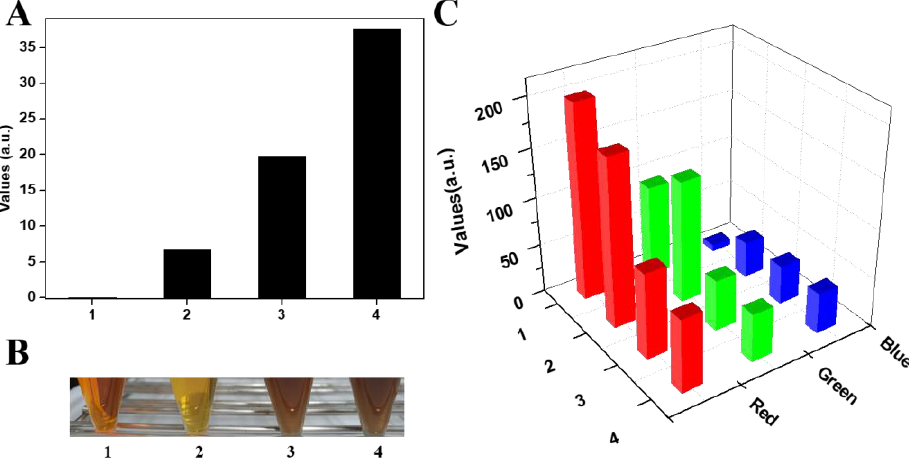
Figure 7. ( A ) Spectral responses for the detection of hydrazine decomposition in the presence of H 2 O 2 (0.2 M) and di ff erent concentrations of Fe 3 + (2 and 32 ppm respectively); ( B ) color changes for di ff erent concentrations of Fe 3 + (2 and 32 ppm respectively); ( C ) RGB profiles for di ff erent concentrations of Fe 3 + (2 and 32 ppm respectively). 1 represents the control without H 2 O 2 and 2, 3, and 4 represent with H 2 O 2, with H 2 O 2 and Fe 3 + (2 ppm), and with H 2 O 2 and Fe 3 + (32 ppm). The concentration of p -dimethylaminobenzaldehyde used was 4 × 10 − 6 M.